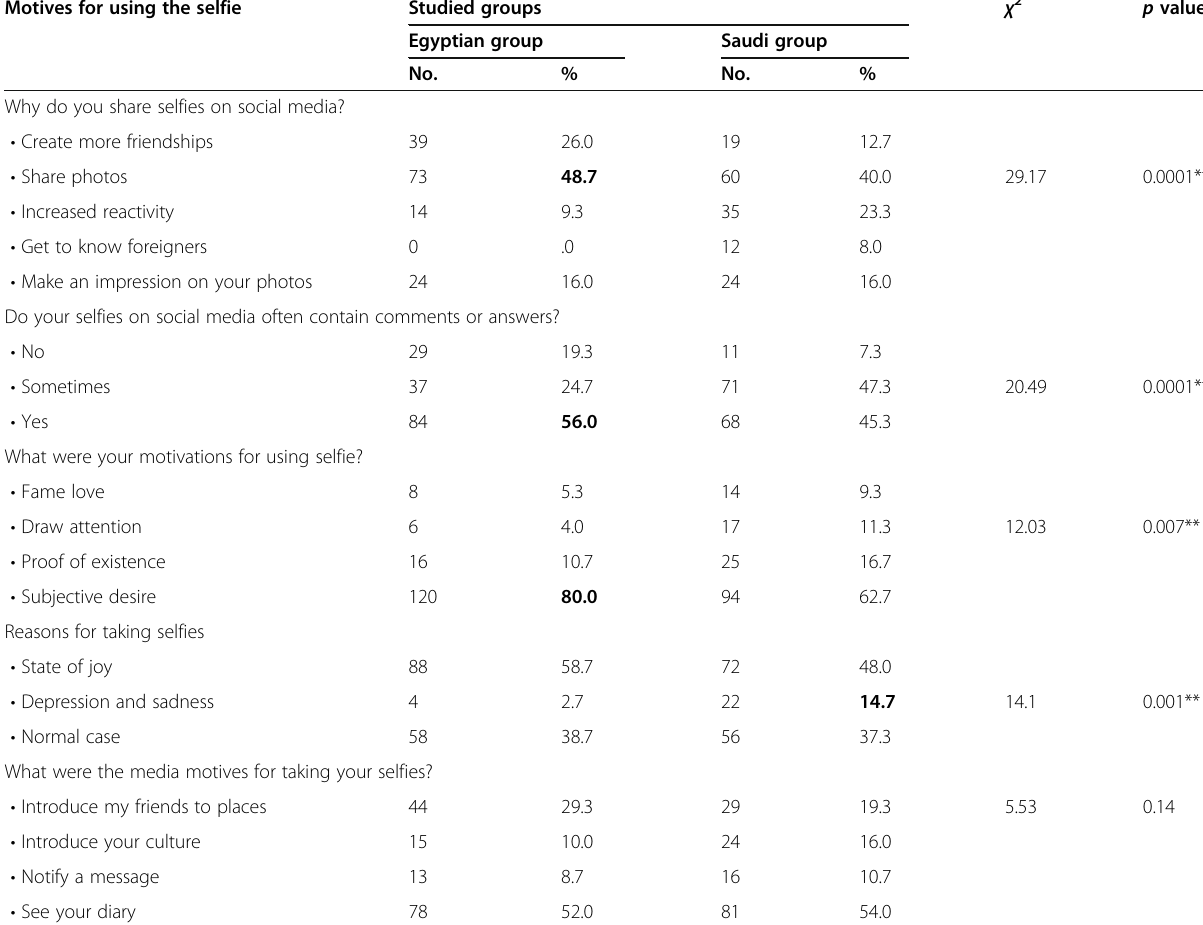
Table 3 Comparison between Egyptian and Saudi nursing students as regards the motives for using the selfie (each group n = 150) Motives for using the selfie Studied